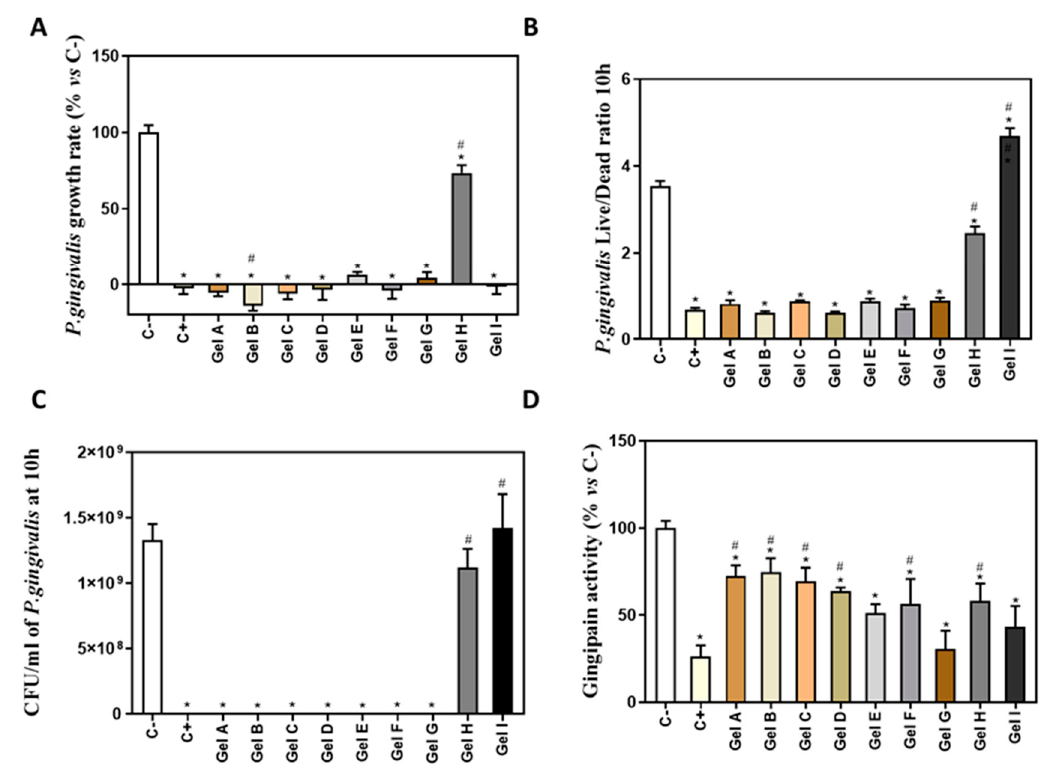
Figure 3. Antimicrobial activity of different periodontal gels. ( A ) P. gingivalis growth rate cultured with different periodontal gels ( n = 6). ( B ) P. gingivalis live/dead ratio after treatment for 10 h with different periodontal gels ( n = 6). ( C ) Number of P. gingivalis CFU/mL after 10 h of incubation with the different treatments ( n = 4). ( D ) In vitro gingipain activity from P.gingivalis after 10 h of treatment ( n = 6). Results are expressed as % vs. Negative control that was set to 100%. Data represent the mean ± SEM. Negative control (C − ) was bacterial suspension without any treatment and positive control (C+) was bacterial suspension with CHX at 0.2%. See Table 1 for the identification of gels used in the study. Results were statistically compared by Kruskal-Wallis for P. gingivalis growth rate and by ANOVA and LSD as post hoc for P. gingivalis live/dead ratio, number of CFU/mL and in vitro gingipain activity: * p < 0.05 treatment vs. negative control. # p < 0.05 treatment vs. positive control.